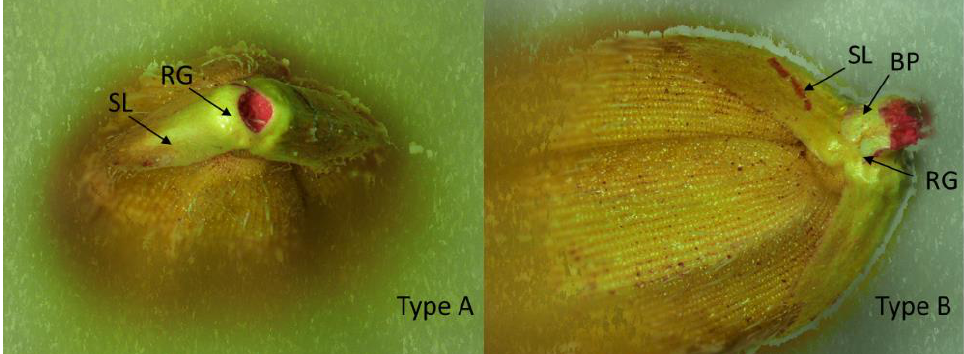
Figure 2. Types of grain shattering. Type A: the seeds were separated between sterile lemma and rudimentary glume; Type B: torn off at a part of the pedicel. SL: sterile lemma; RG: rudimentary